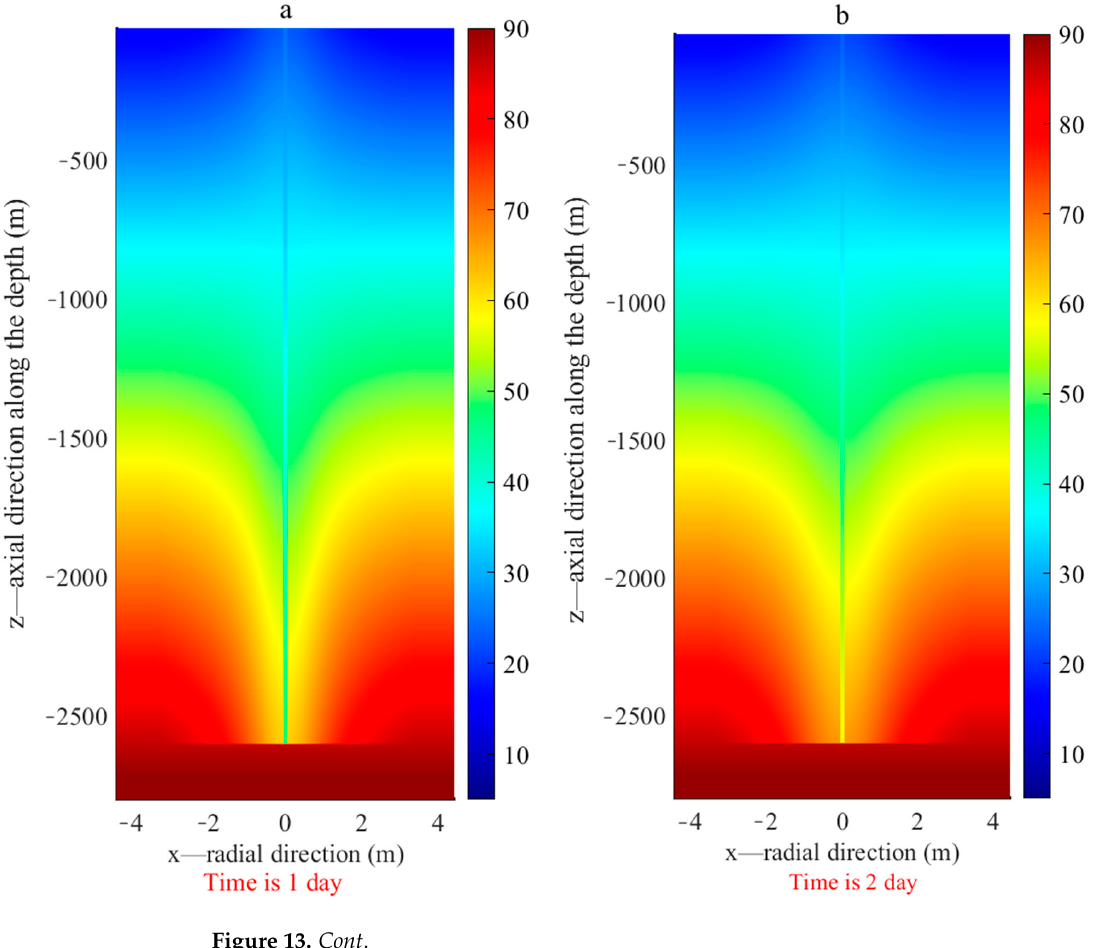
Figure 12. Rock temperature distribution underground during the low temperature heat storage days (( A – D ) depict the simulation results at 1 day, 10 day, 20 day, 30 day respectively from the proposed model; ( a – d ) show the corresponding results from the OGS software).